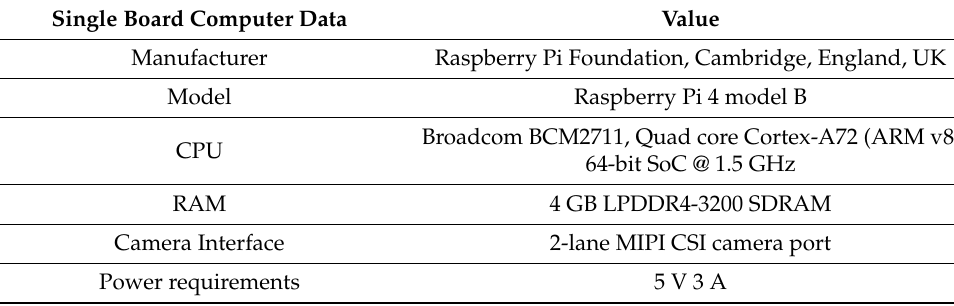
Table 1. Table of single board computer specifications